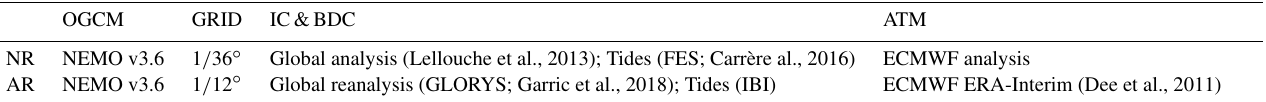
Table 1. The nature run (NR) and assimilated run (AR) configurations. The rows show the OGCM configurations used to obtain the na- ture run (NR) and the assimilated run (AR). The columns show the OGCM used, the horizontal resolution (GRID), the initial (IC) and boundary (BDC) conditions and the atmospheric forcings (ATM) considered in each configuration.